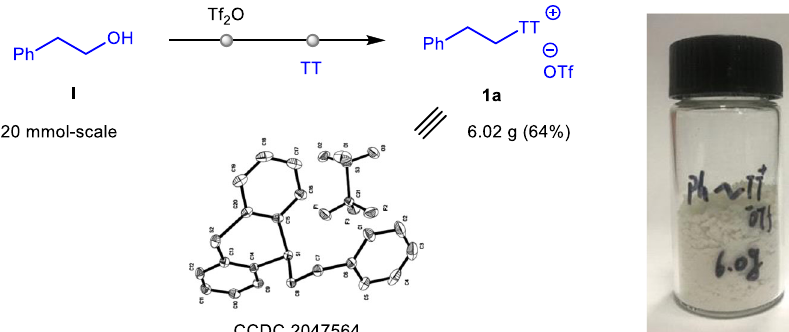
Fig. 2 General procedures to access S -(alkyl) thianthrenium salts. Synthesis of S -(alkyl) thianthrenium salt 1a from the related alcohol I .